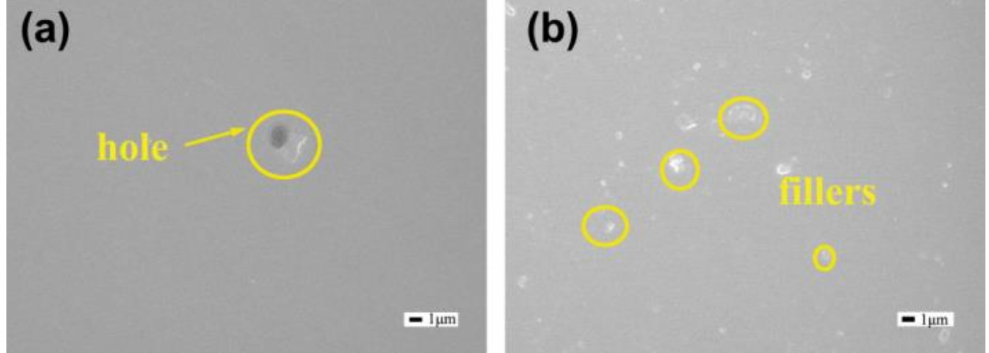
Figure 6. Scanning electron microscopy (SEM) images of surface morphology of ( a ) Blank coating and ( b ) M + V